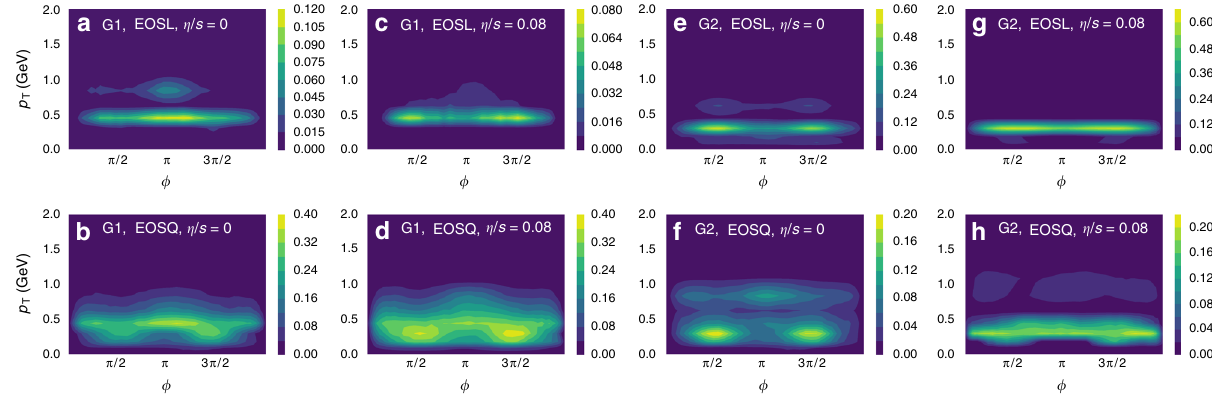
Fig. 2 Importance maps of the particle momentum distribution. The values in the scale bar represent the relative importance of each bin for classi fi cation computed using the Prediction Difference Analysis method by averaging over about 800 events for each category. EOSL in the fi rst row represents the equation of state with a smooth crossover, EOSQ in the second row represents a fi rst-order phase transition equation of state. The G1 in a – d represents the testing data set Group 1 from iEBE-VISHNU model while G2 in e – h represents the testing data set from CLVisc + IP-Glasma model. The η / s = 0 in a , b , e , f represents ideal hydrodynamics while η / s = 0.08 in c , d , g , h represents viscous hydrodynamics with shear viscosity over entropy density ratio 0.08